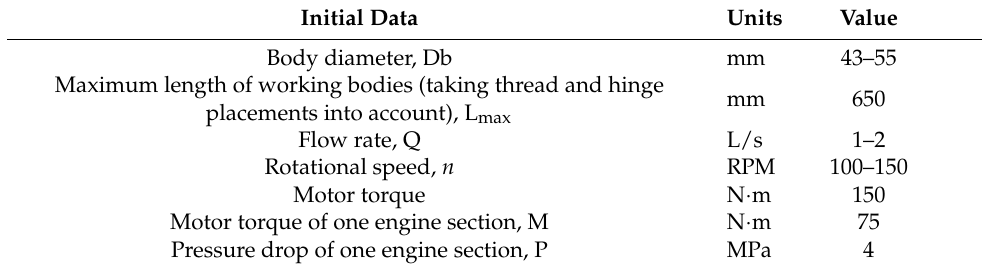
Table 1. Initial data for calculating PDM